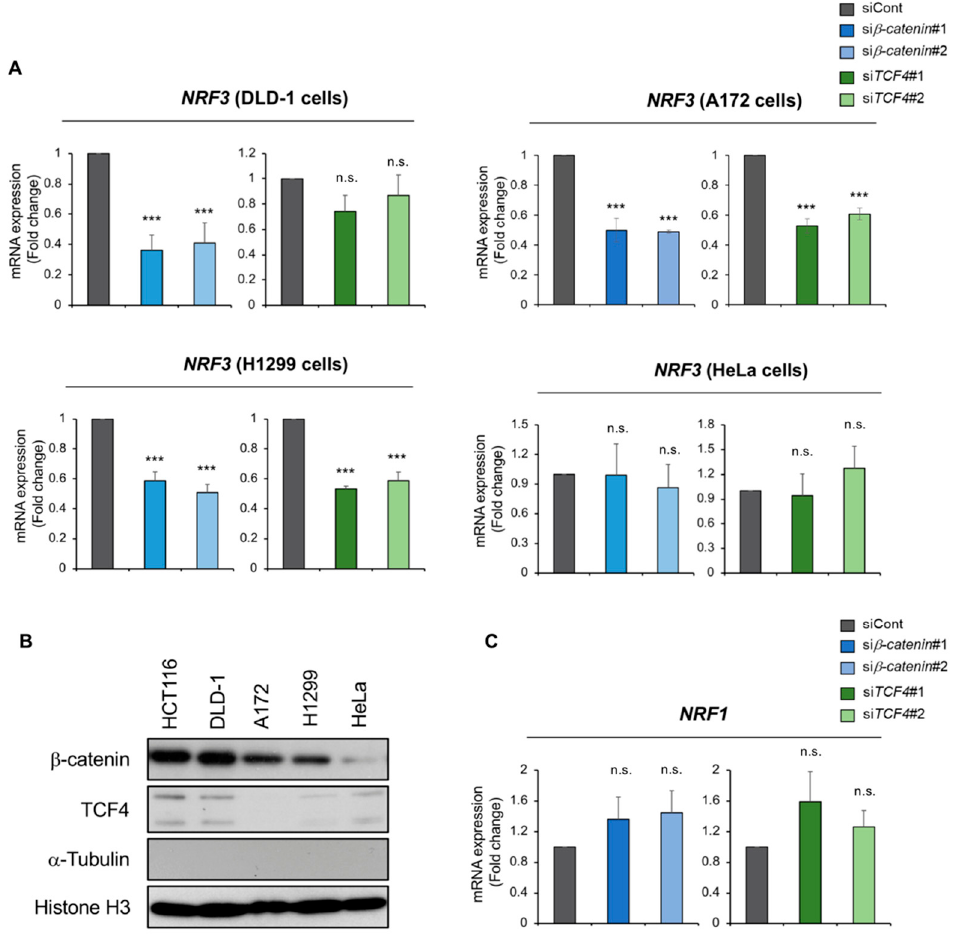
Figure 3. The β -catenin/TCF4 complex induces NRF3 gene expression in cancer cell lines with mutations in the Wnt- β -catenin pathway. ( A ) Knockdown of β -catenin or TCF4 was performed in DLD-1, A172, H1299 (mutated Wnt- β -catenin system) and HeLa cells (intact Wnt- β -catenin system). The experiment was performed as described in the legend for Figure 2. ( B ) Nuclear localization of β -catenin and TCF4 in cancer cells. Nuclear extracts from the indicated cells were prepared and subjected to western blot analyses. Histone H3 served as a loading control. The absence of α -Tubulin in the extracts indicates no cytoplasmic fraction contamination. ( C ) qRT-PCR analysis of NRF1 upon β -catenin or TCF4 knockdown in HCT116 cells. mRNA expression levels were normalized to β -actin expression, and the data are presented as the mean ± SD ( n = 3). *** p < 0.005, n.s., not significant (ANOVA-Tukey in A and C ).